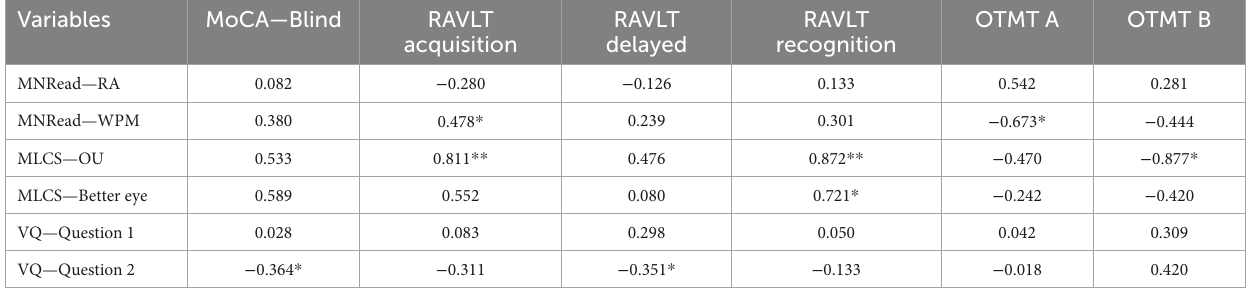
TABLE 5 Pearsonès correlation coefficients among cognitive and vision